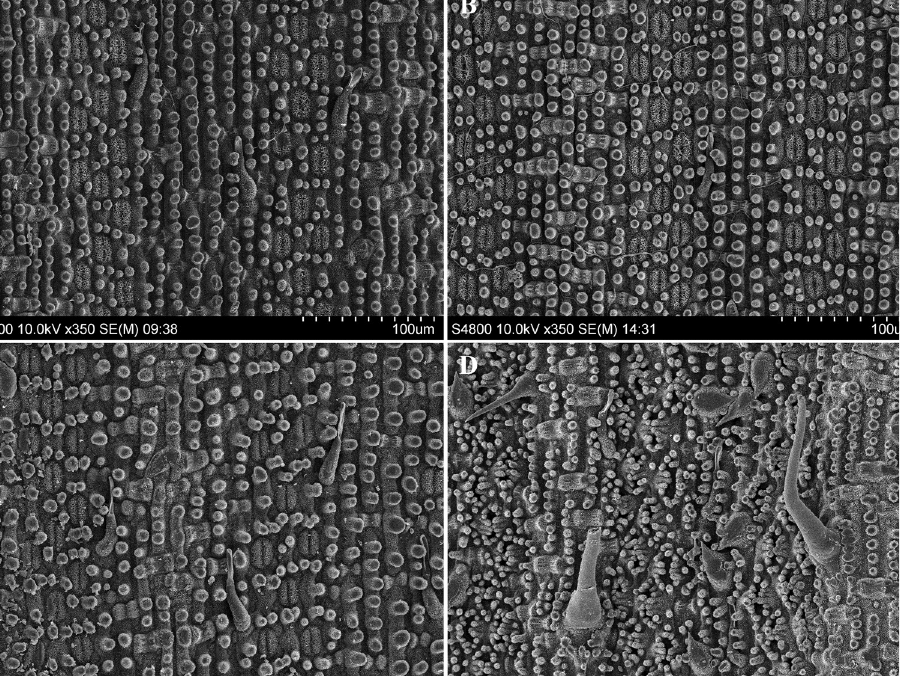
Figure 2. SEM images of the abaxial leaf epidermis. A Xunwu plants (Xunwu, Jiangxi, China) B Gelido- calamus stellatus (Jinggang Mountain, Jiangxi, China). C Gelidocalamus tessellatus (Libo, Guizhou, China) D Gelidocalamus dongdingensis (Longyan, Fujian, China).